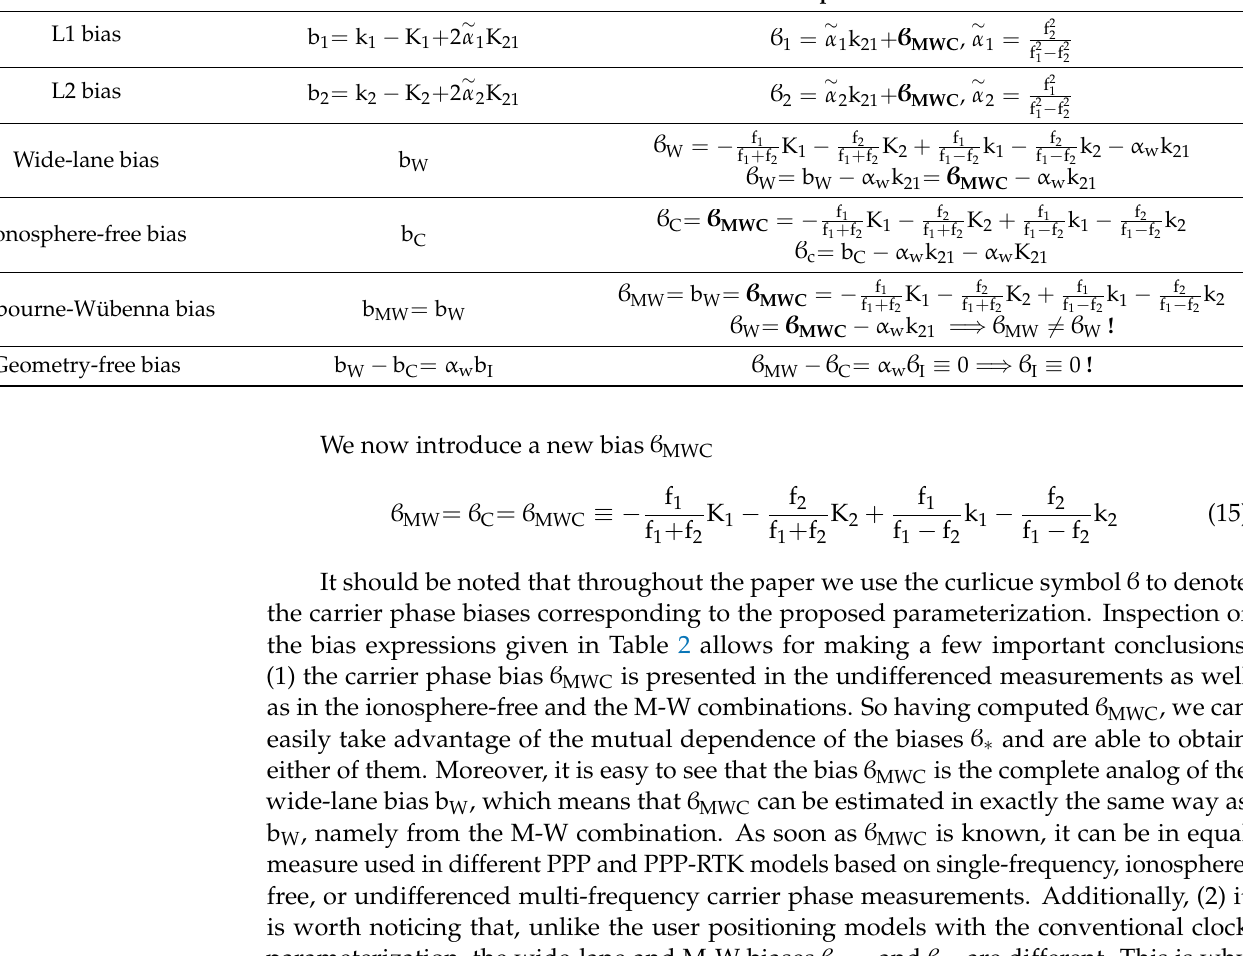
Table 2. Comparison of the carrier phase biases for the two clock parameterizations (1) and (14). Bias Conventional Parameterization Proposed